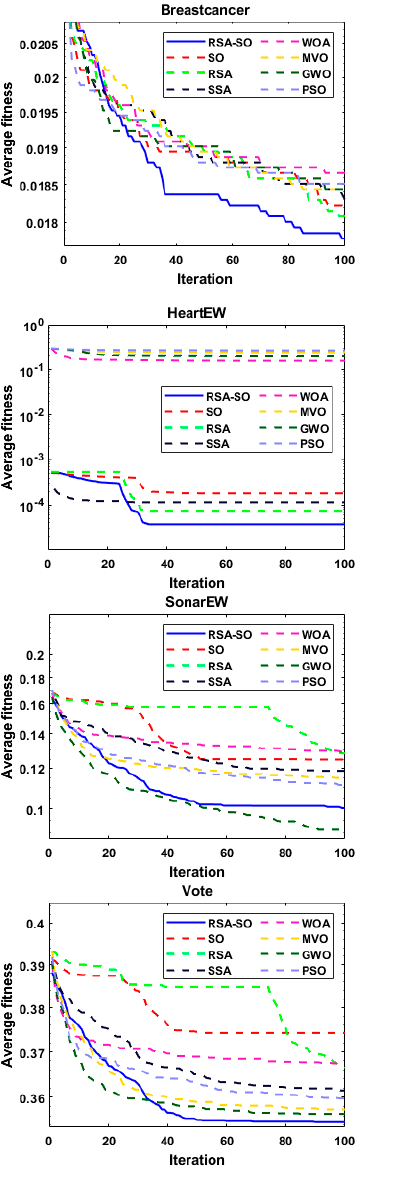
Figure 4. Convergence curves of the RSA ‐ SO and the other methods.